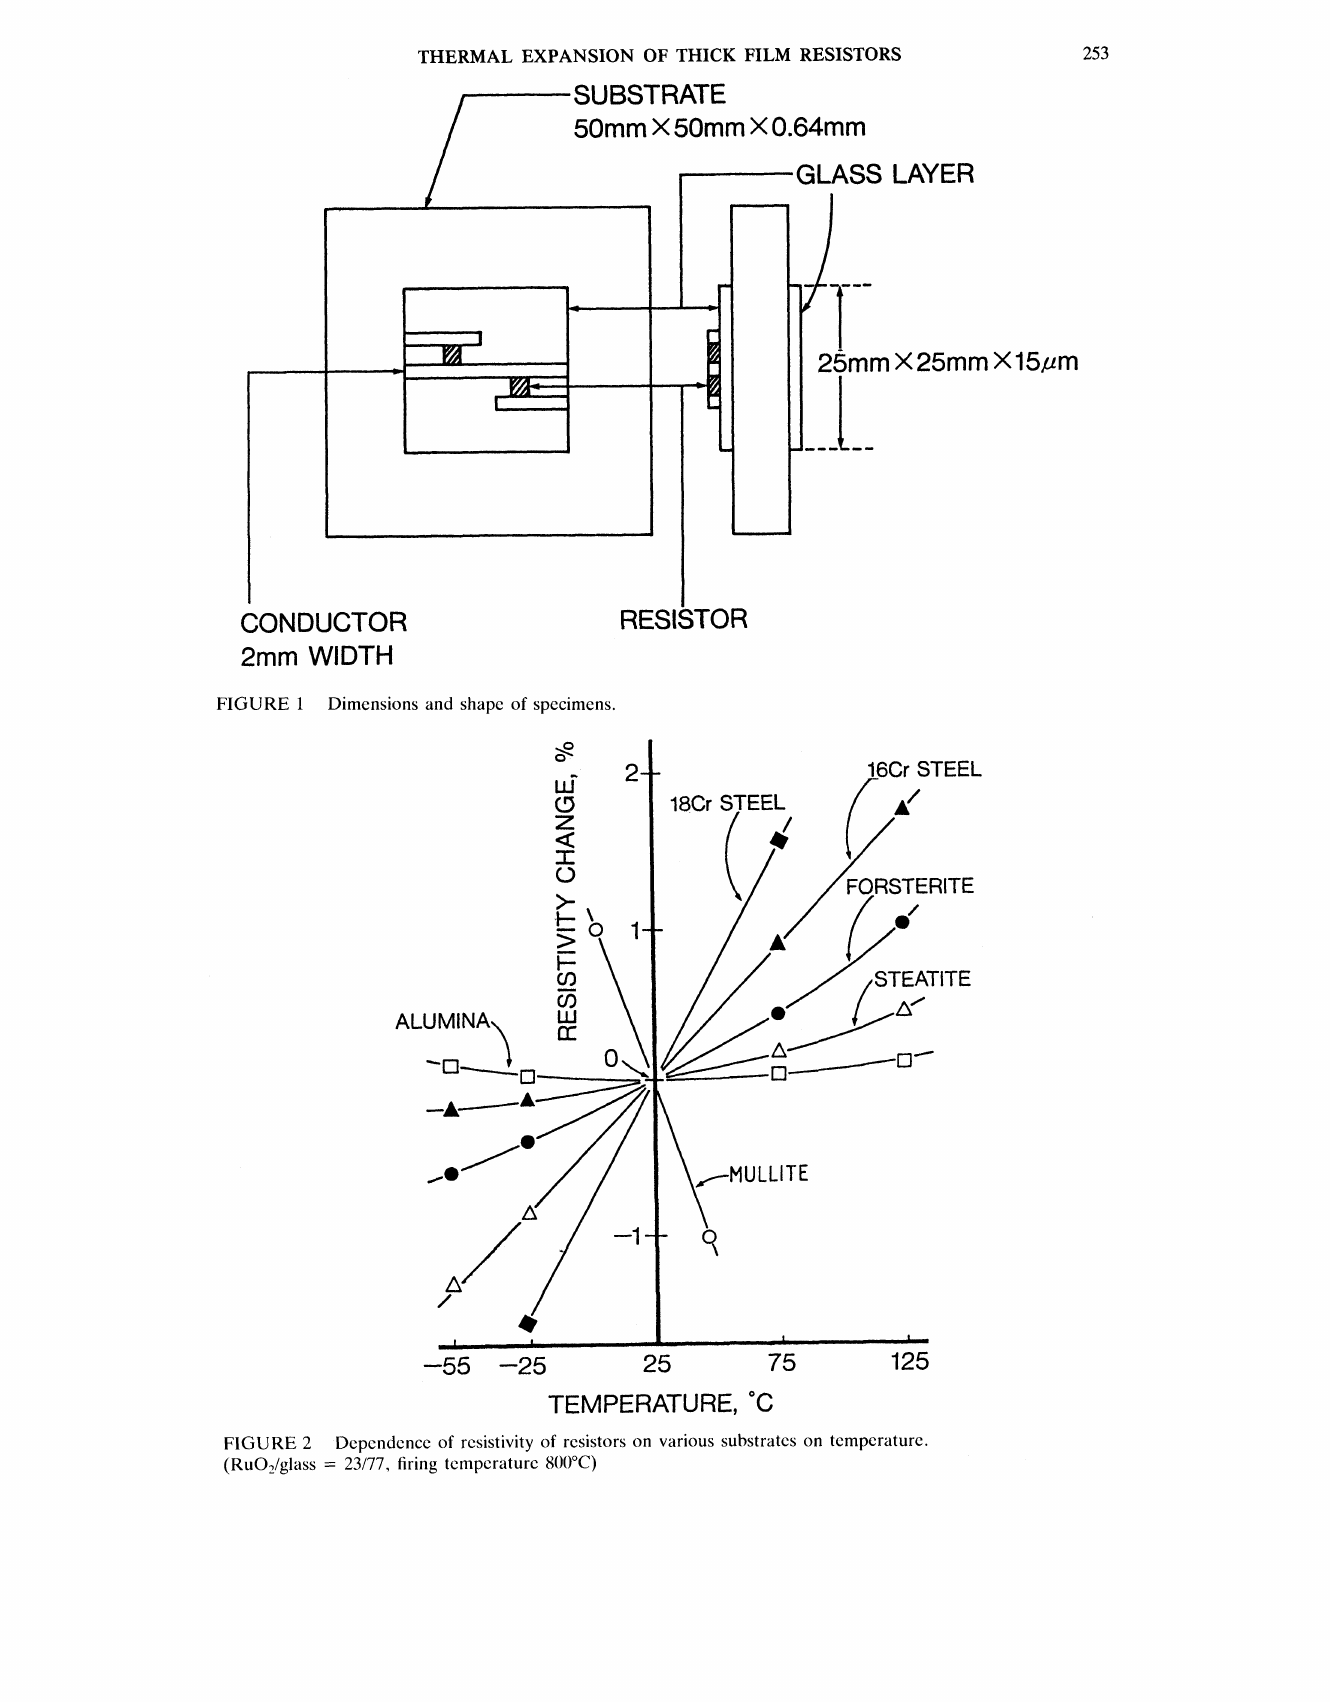
FIGURE 2 Dependence of resistivity of resistors on various substratcs on temperature. (RuO2/glass 23/77, firing temperature